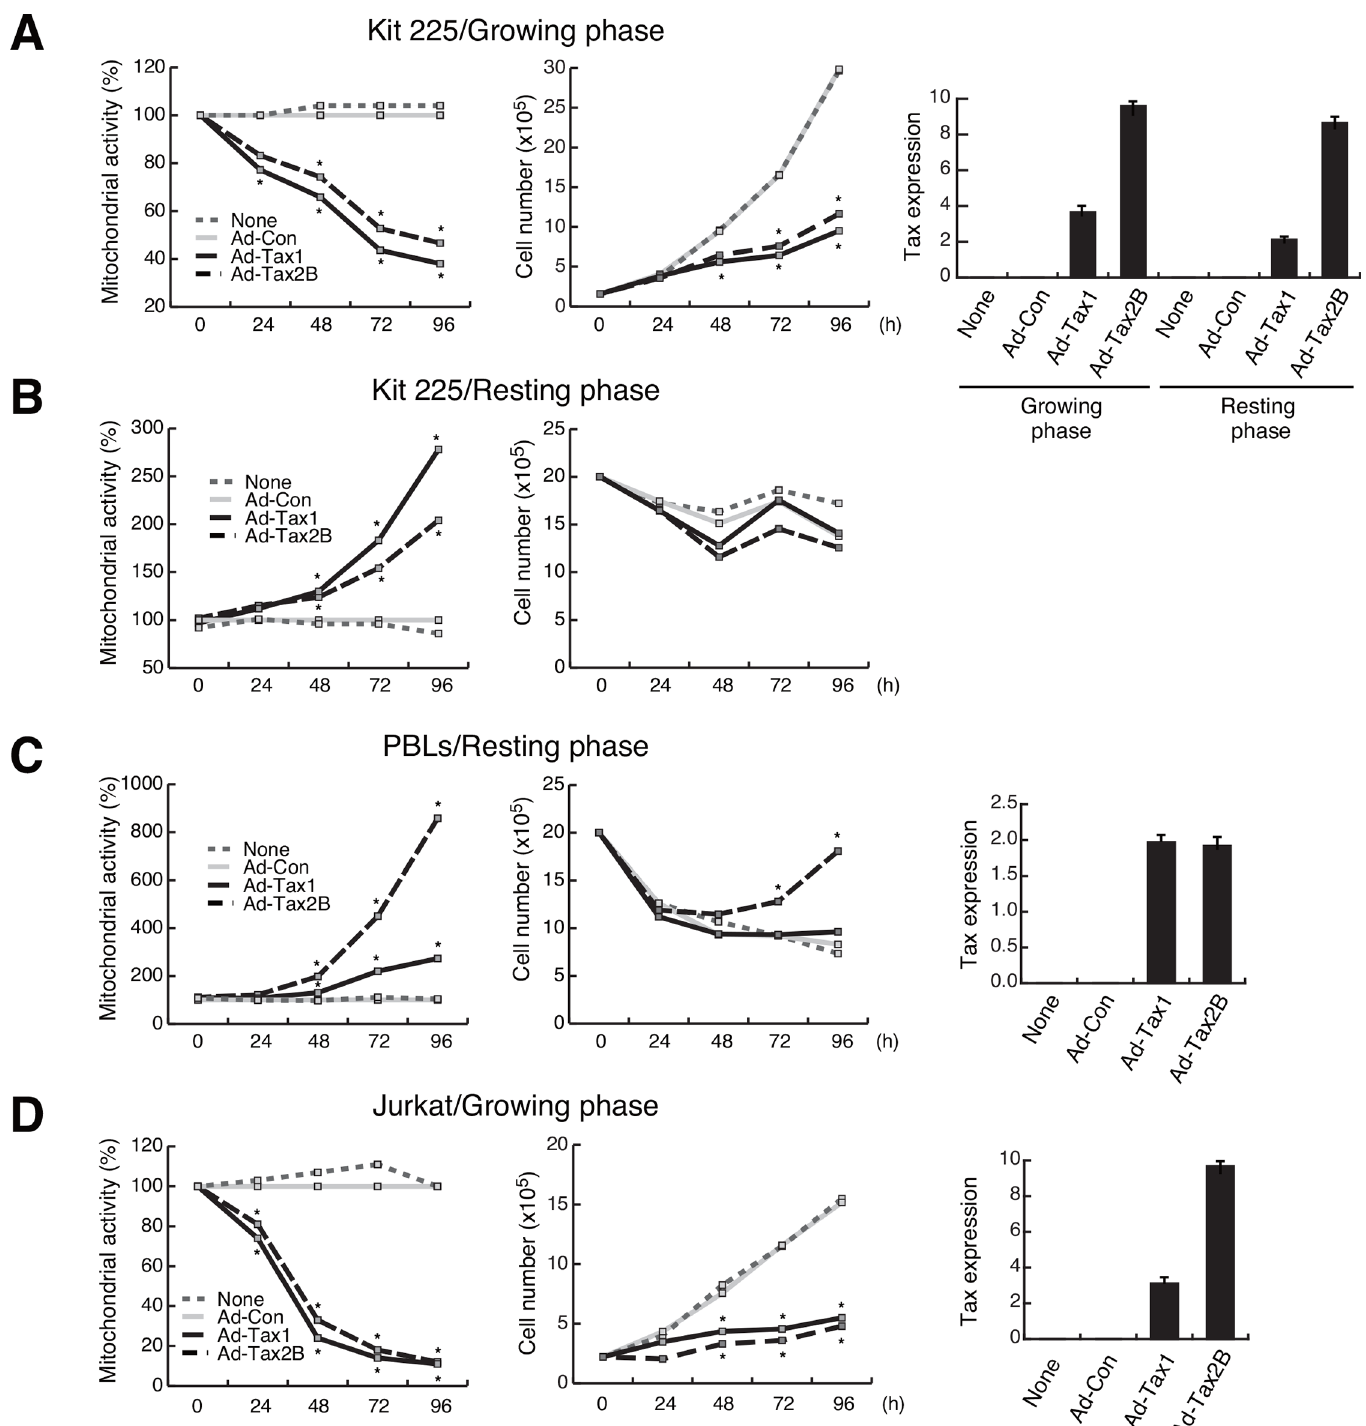
Fig 2. Differential effects of Tax1 on cell proliferation. Growing (A) or resting (B) Kit 225 cells, PBLs (C) and Jurkat cells (D) were infected with Ad-Tax1, Ad-Tax2B or Ad-Con, and cultured for the indicated times. Mitochondrial activity was measured by the MTT assay and the cells were enumerated. Relative percentages of Ad-Tax1 or Ad-Tax2B samples to Ad-Con samples are shown. * , p < 0.05. Tax expression was monitored by qPCR. Values are shown as the means of the copy numbers ± SE after normalization against 18 S rRNA content.